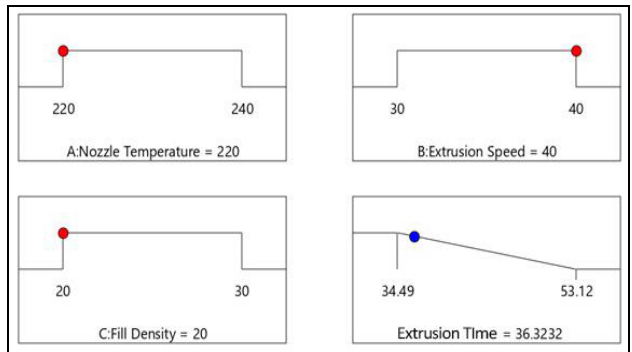
Fig. 12. Optimal parameters for extrusion time from RSM